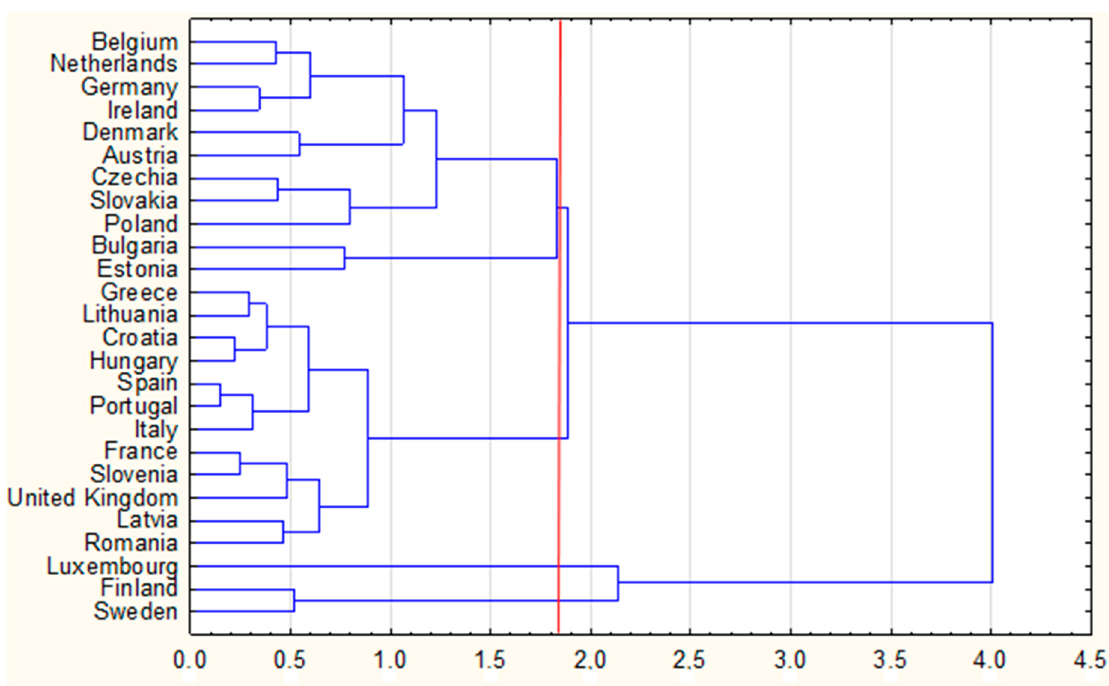
Figure 6. Dendrogram for 2018 using the Ward method.